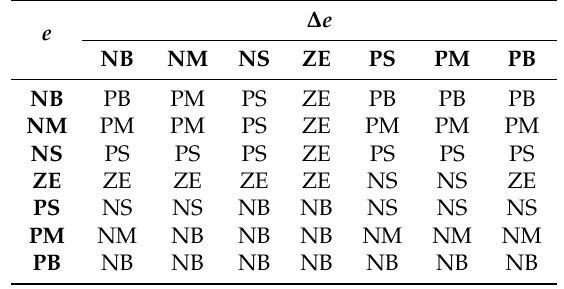
Figure 8. Input-output surface graph. Table 1. Fuzzy proposed rule